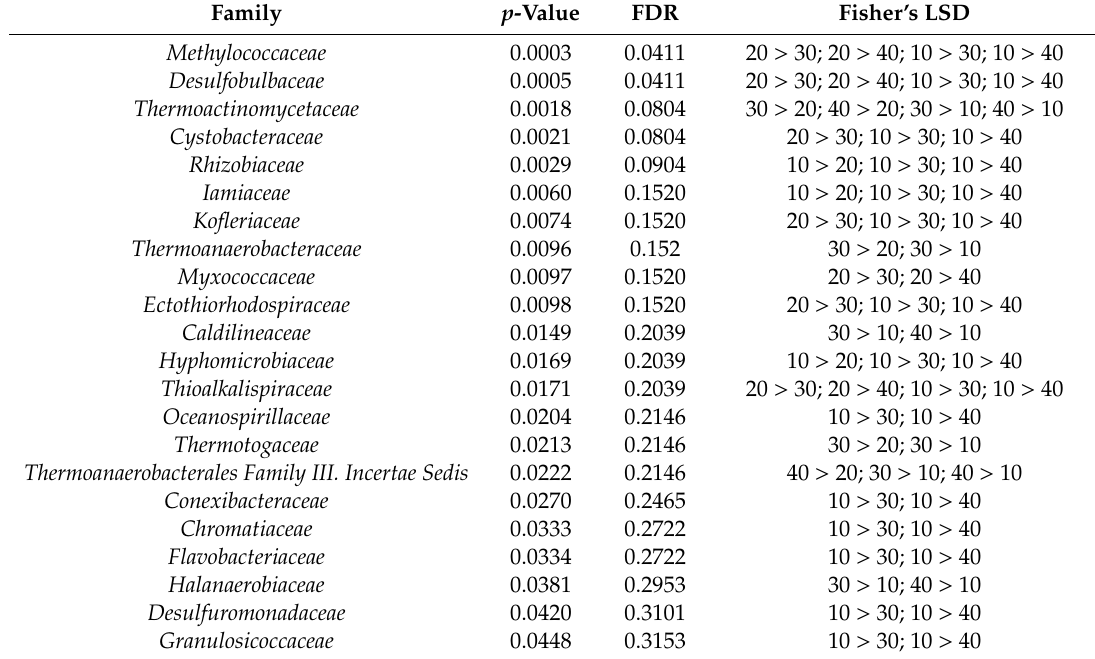
Table 4. Summary of taxonomic classification based on core depth bacterial 16S sequencing data from Moreton Bay marine sediment using one-way ANOVA